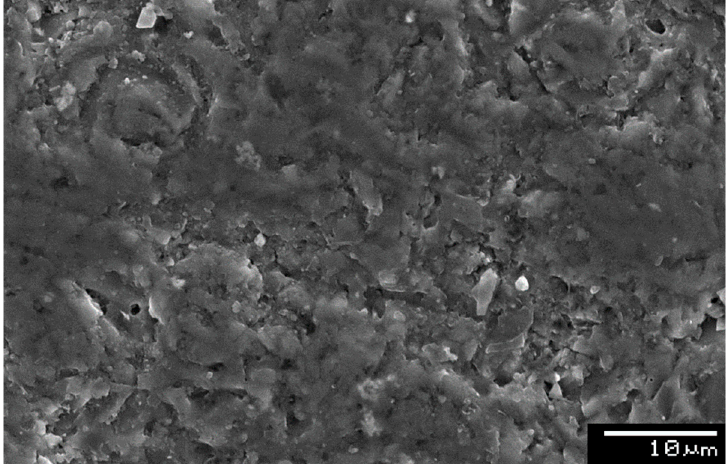
Figure 3. Group C: surface treatment of the CO 2 laser on the ceramic surface at ×2000 under SEM.